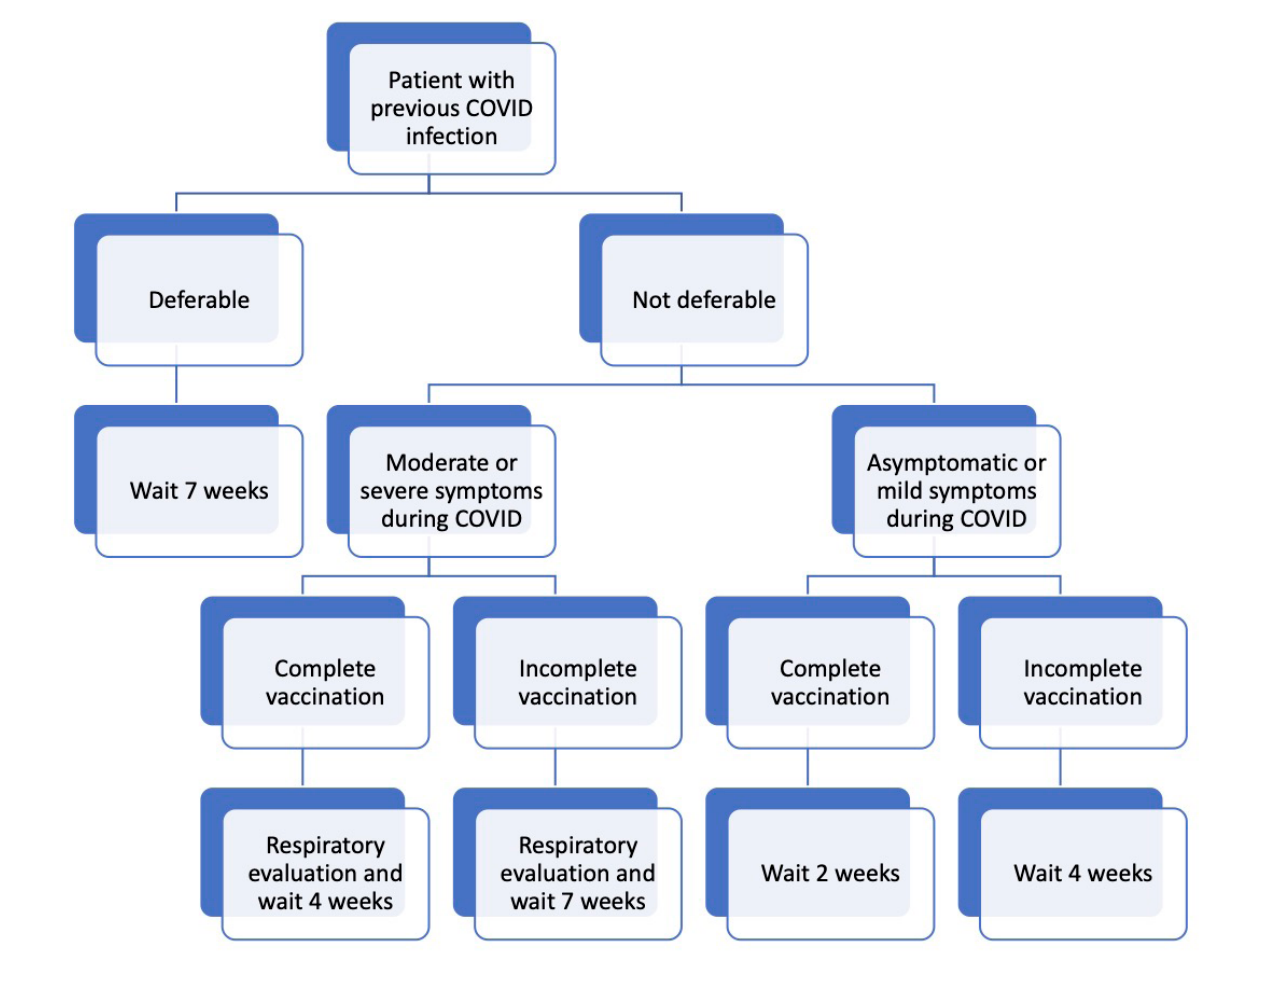
Fig. 2 - Recommendation algorithm for timing of cardiac surgery in patients with previous coronavirus disease 2019 (COVID-19)